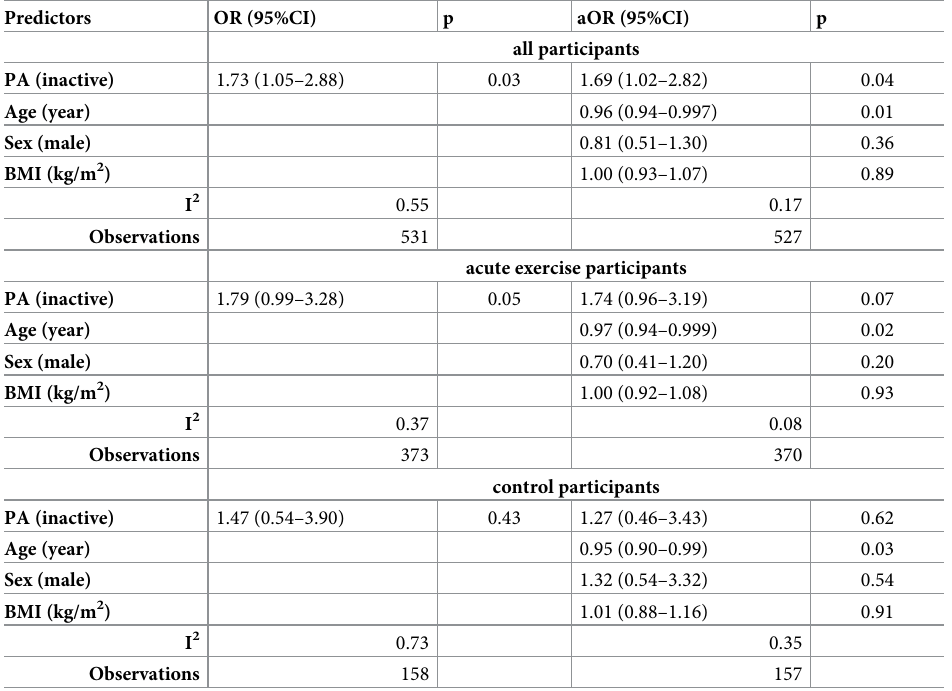
The effect of physical activity (PA) level on influenza H1 antibody seroconversion by acute exercise: linear regression (unadjusted and adjusted modelling) on seroconversion. Estimates are given with 95%CI in parentheses. Predictors are by unit increase (age and BMI) or versus dichotomous comparator (PA level and sex). Odds ratios are given with 95%CI in